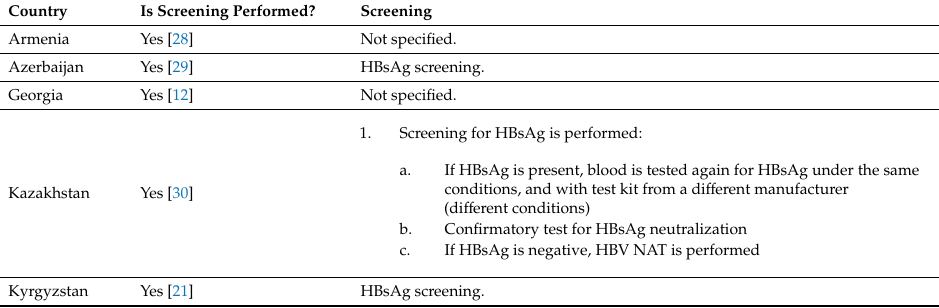
Table 2. Screening for HBV in blood donors. Sources of information are mentioned in parenthesis; n / a, not